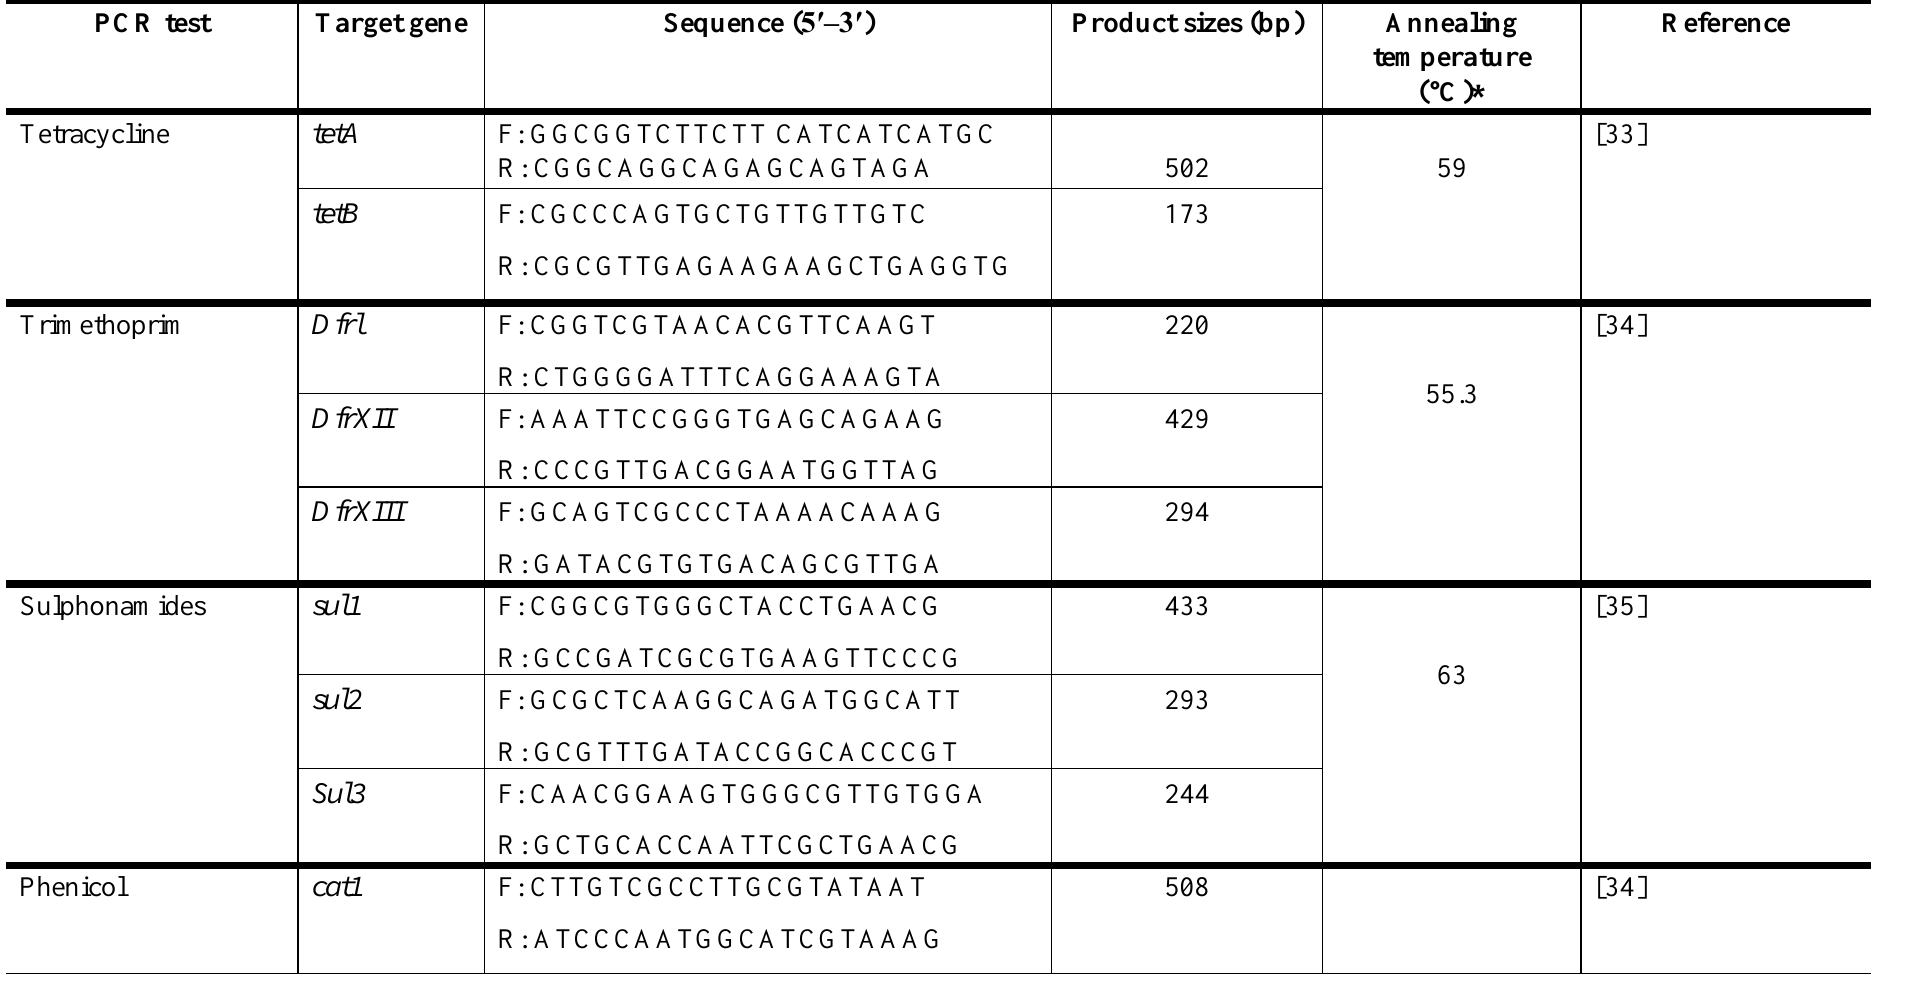
TABLE S5: Primer sequences and PCR conditions for antimicrobial resistance genes used for in the